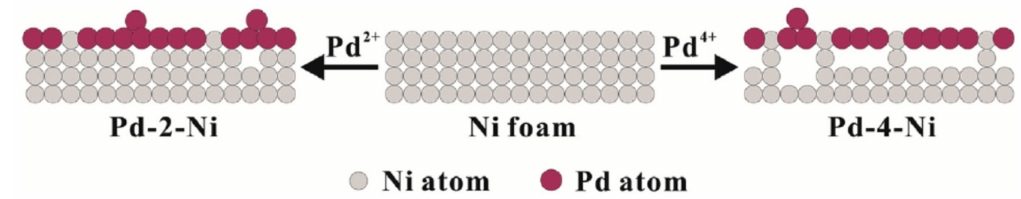
Figure 4. The formation of bifunctional catalyst Pd-Ni atom on NF for methanol electro-oxidation reaction by using the galvanic replacement method. Reprinted with permission from Ref [58]. Copyright 2016